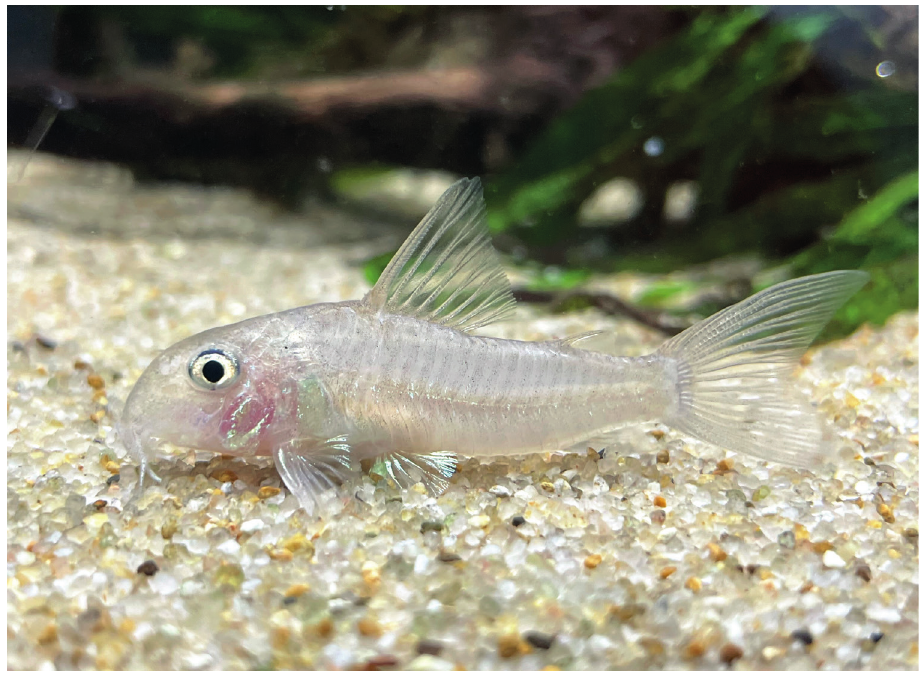
FIGURE 14 | Uncatalogued aquarium specimen of Corydoras psamathos photographed alive. Photo by Takayuki